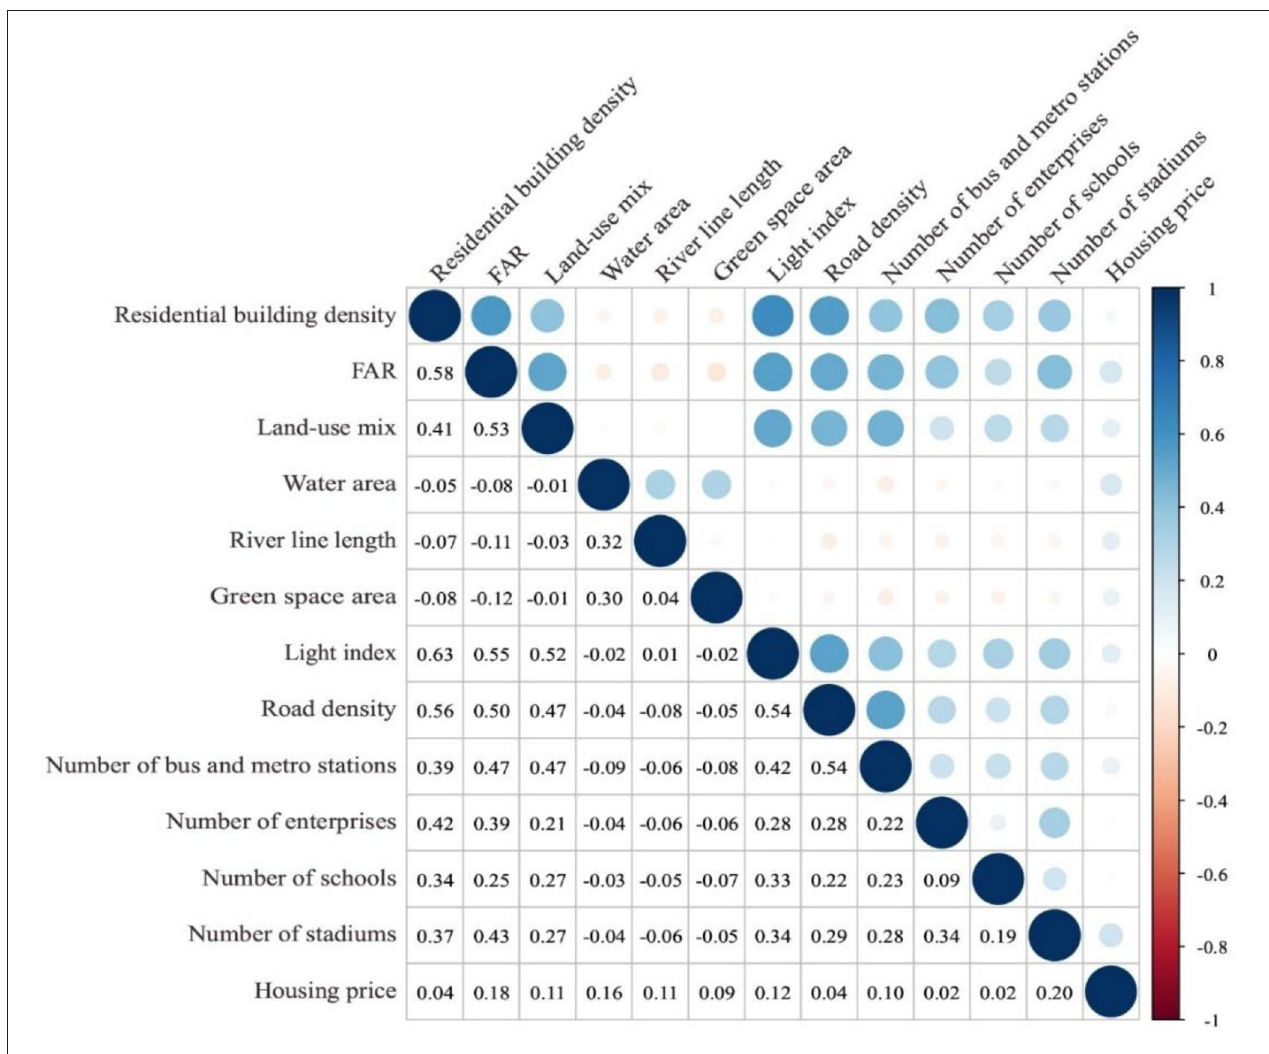
FIGURE 3 | Pair-wise correlation analysis